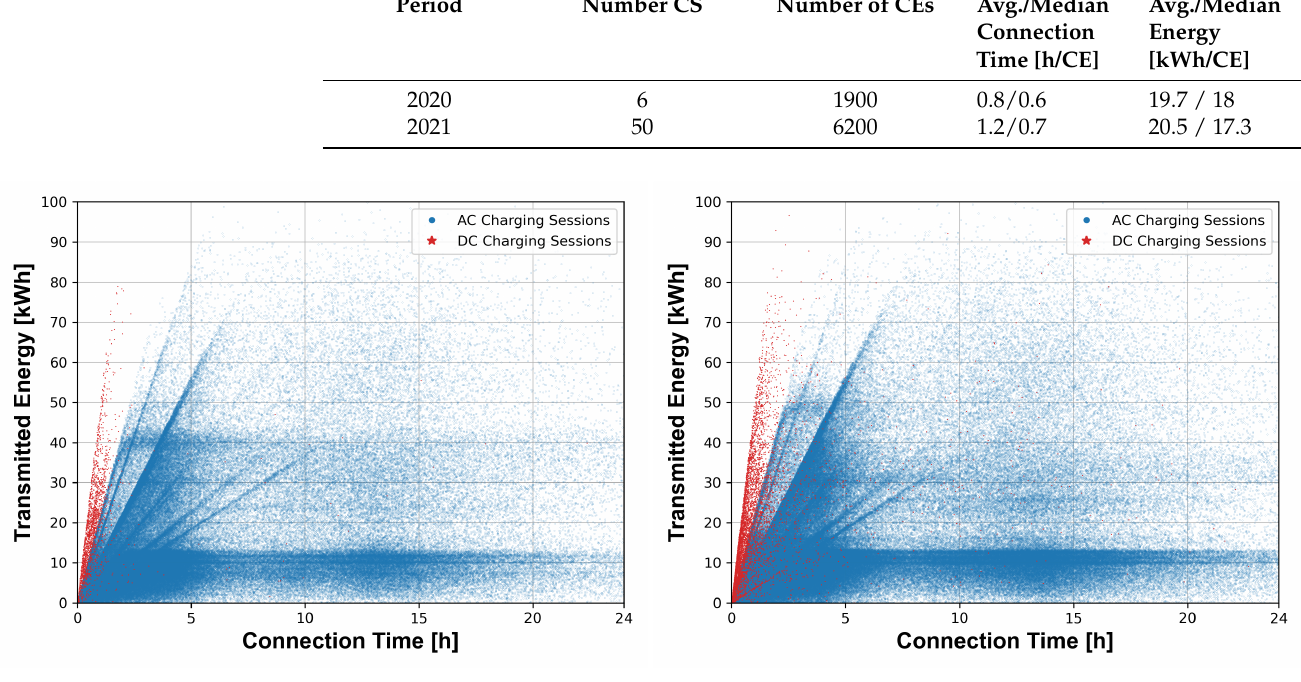
Figure 6. Connection Time and Transmitted Energy for AC and DC Charging Events from CDRs. The clustering of the plotted points already shows an implicit probability